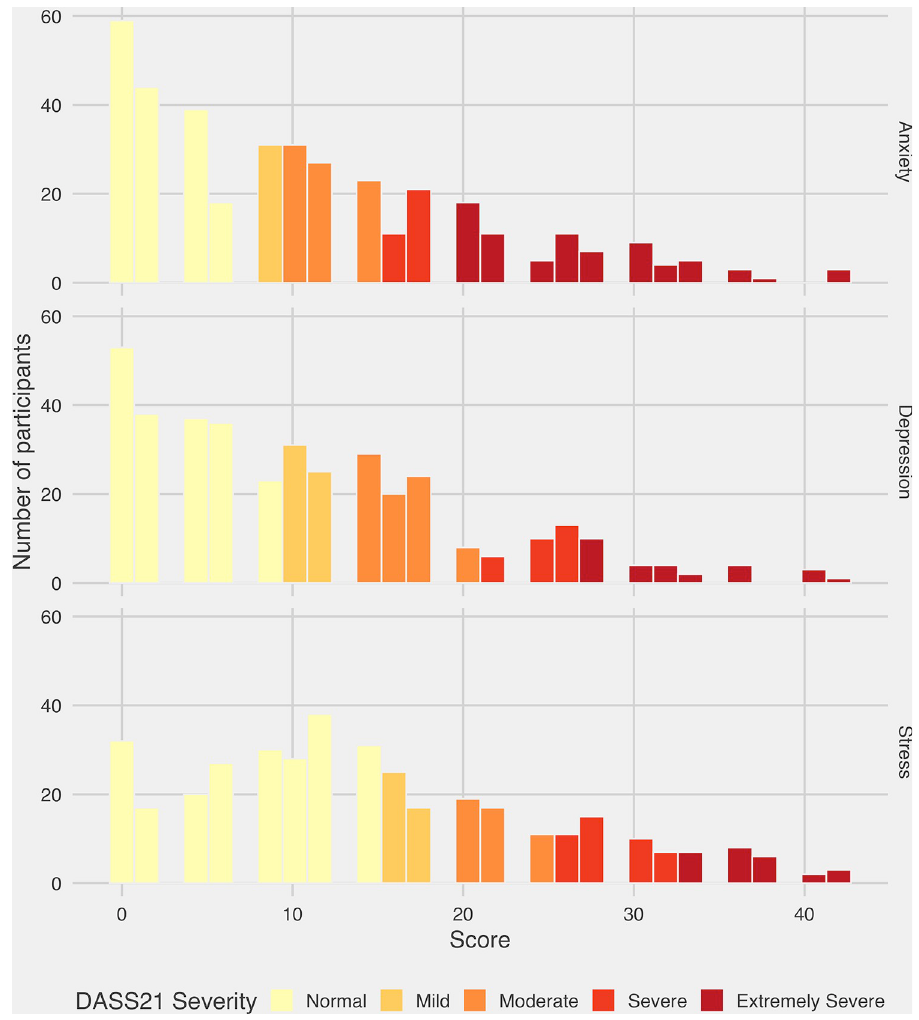
Fig 1. Histograms showing the distribution of DASS-21 scores for each of the three measures; anxiety, depression and